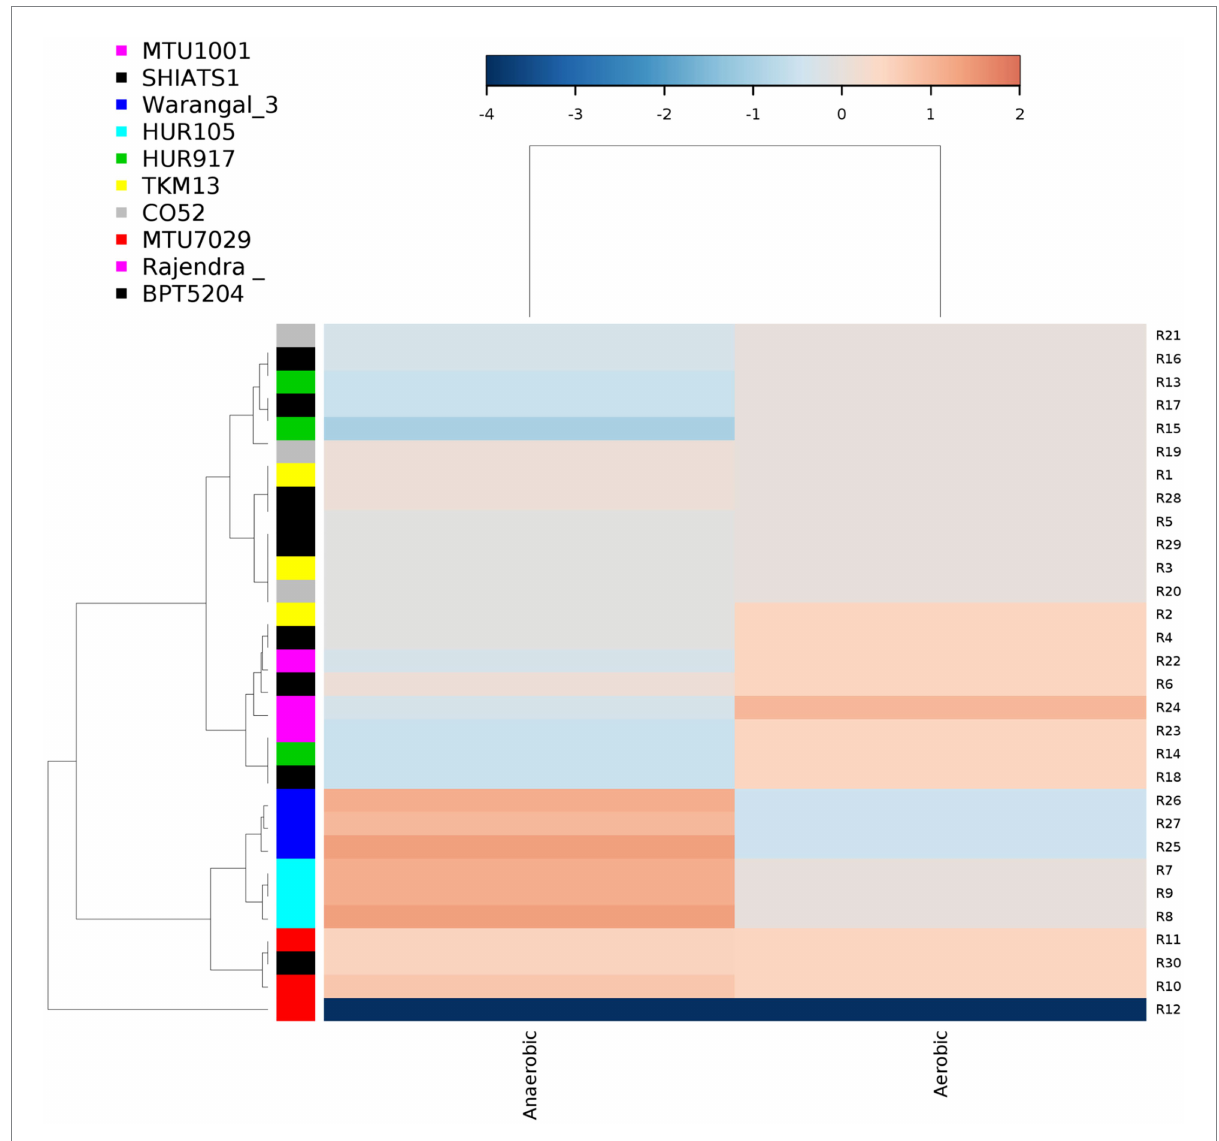
FIGURE 4 Distribution of aerobic and anaerobic bacterial flora in the rhizo-microbiome of rice varieties. For clustering Euclidean distances were estimated, the color gradient toward brown indicates higher abundance whereas lighter shades represent low abundance.